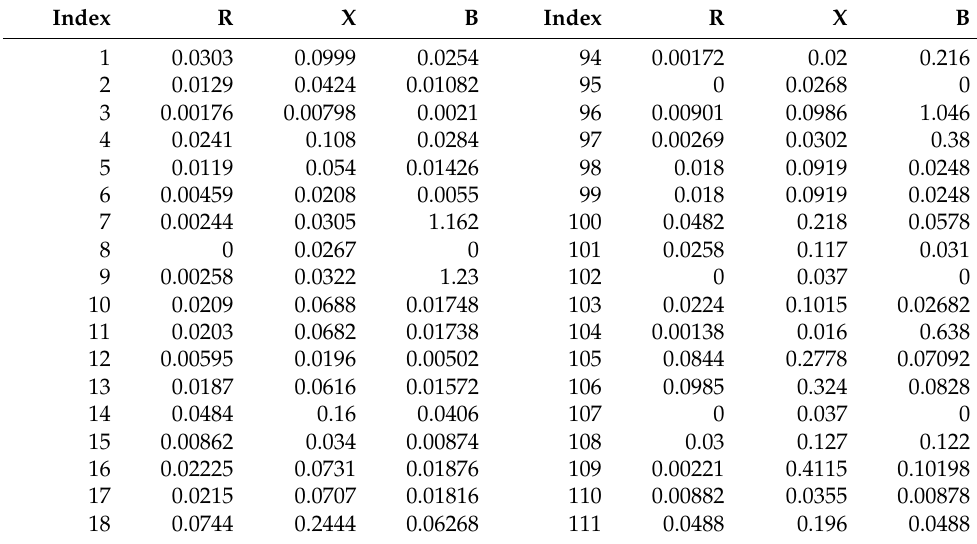
Table A2. IEEE 118 bar system bus